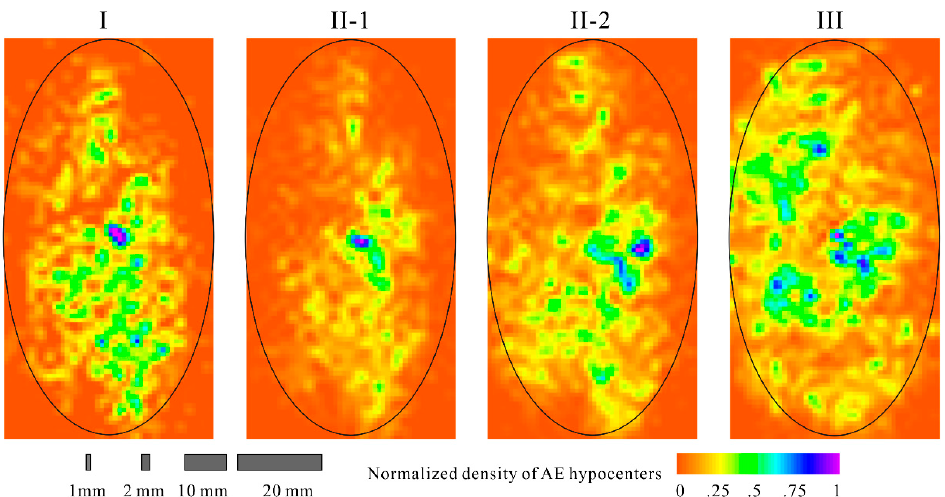
Figure 6. Normalized density distribution of AE hypocenters on the fault plane for the pre-failure phases (stages I, II-1, II-2, and III, as indicated in Figure 4).